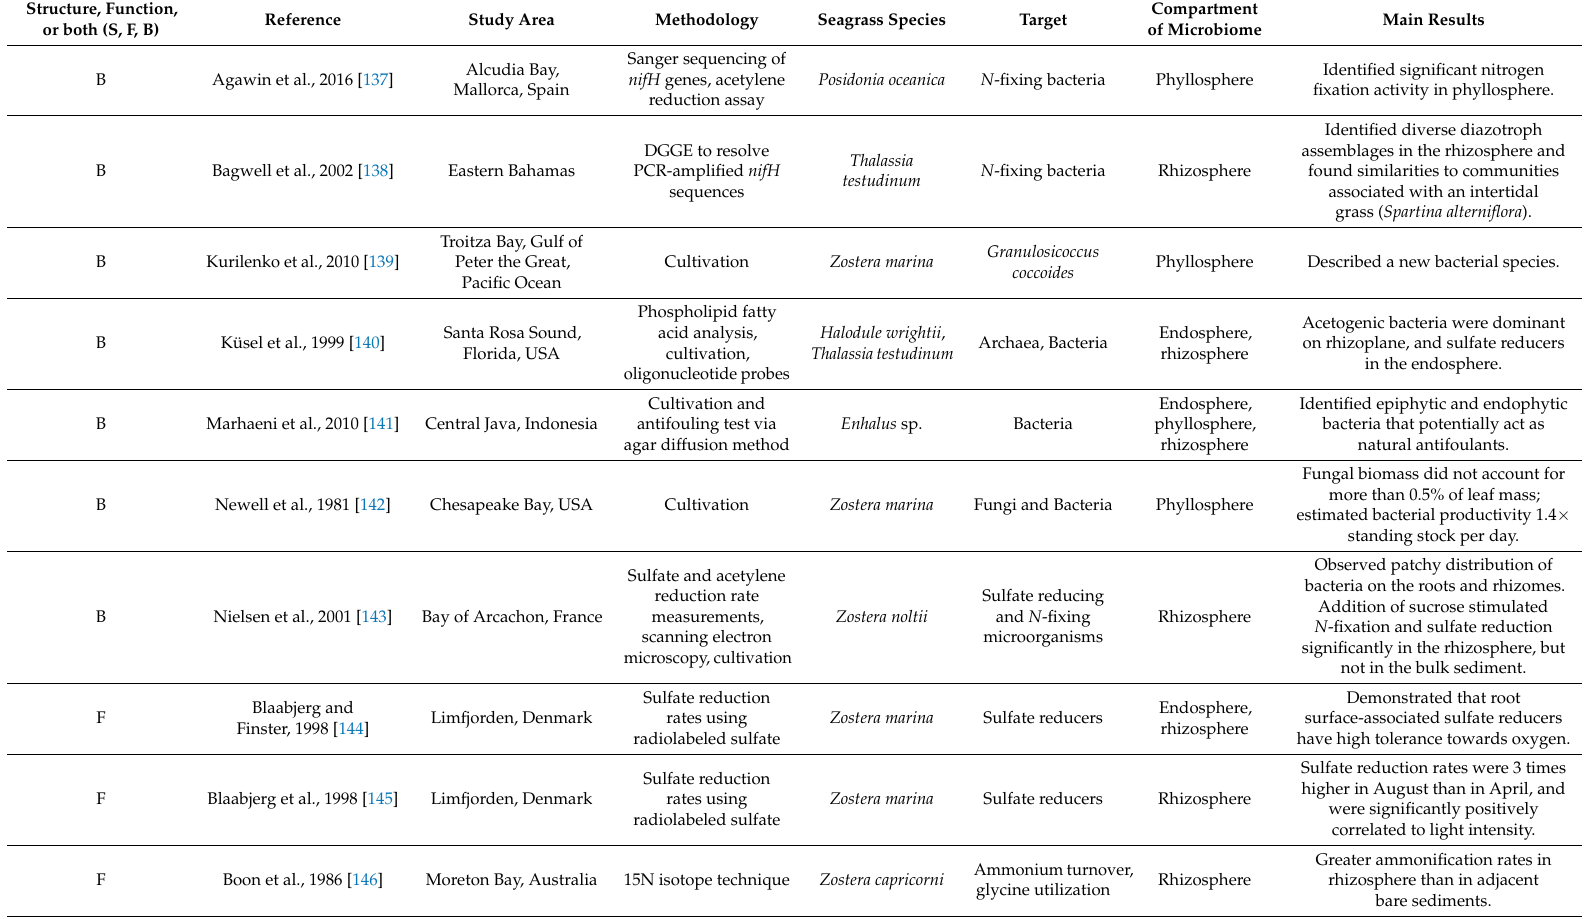
Table 2. Detailed overview on studies on the microbiome of